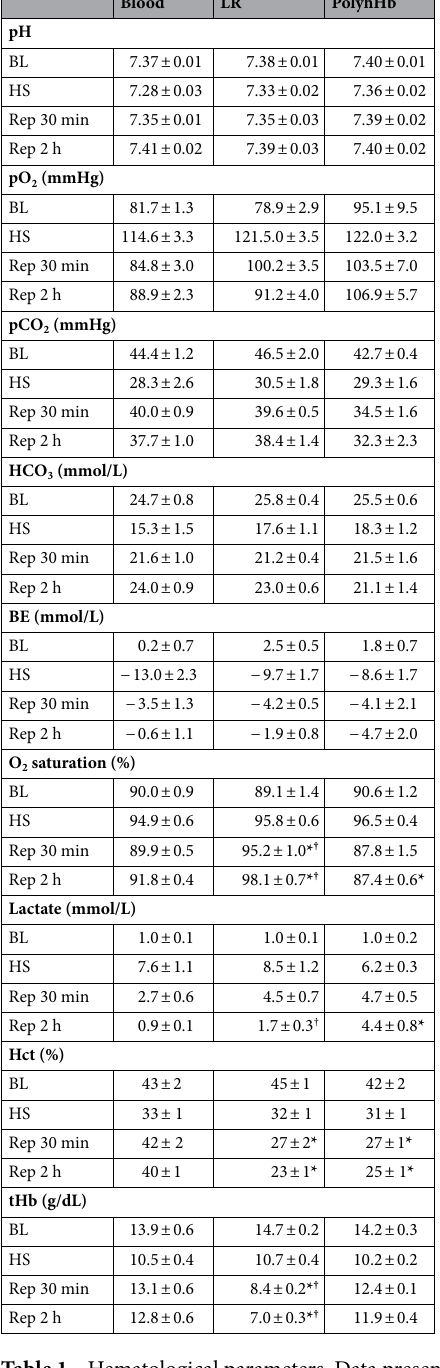
Table 1. Hematological parameters. Data presented as mean ± SE. N = 5/group. BL baseline, HS hemorrhagic shock, LR lactated Ringer’s solution. *p < 0.05 vs. blood group. † p < 0.05 vs. PolyhHb